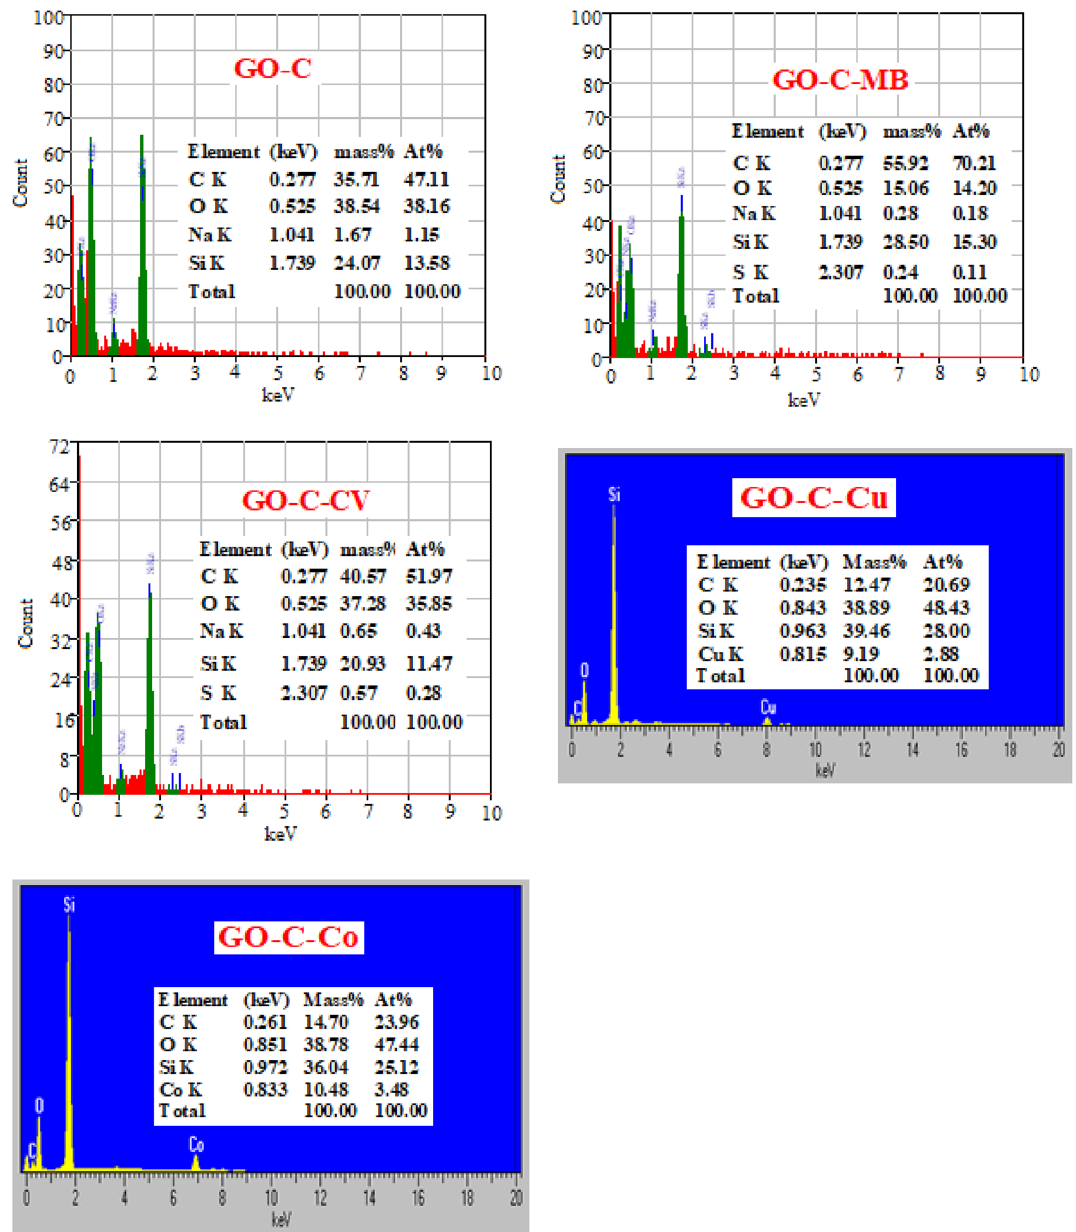
Figure 4. EDS analysis for GO–C composite, GO–C–MB complex, GO–C–CV complex, GO–C–Co complex and GO–C–Cu